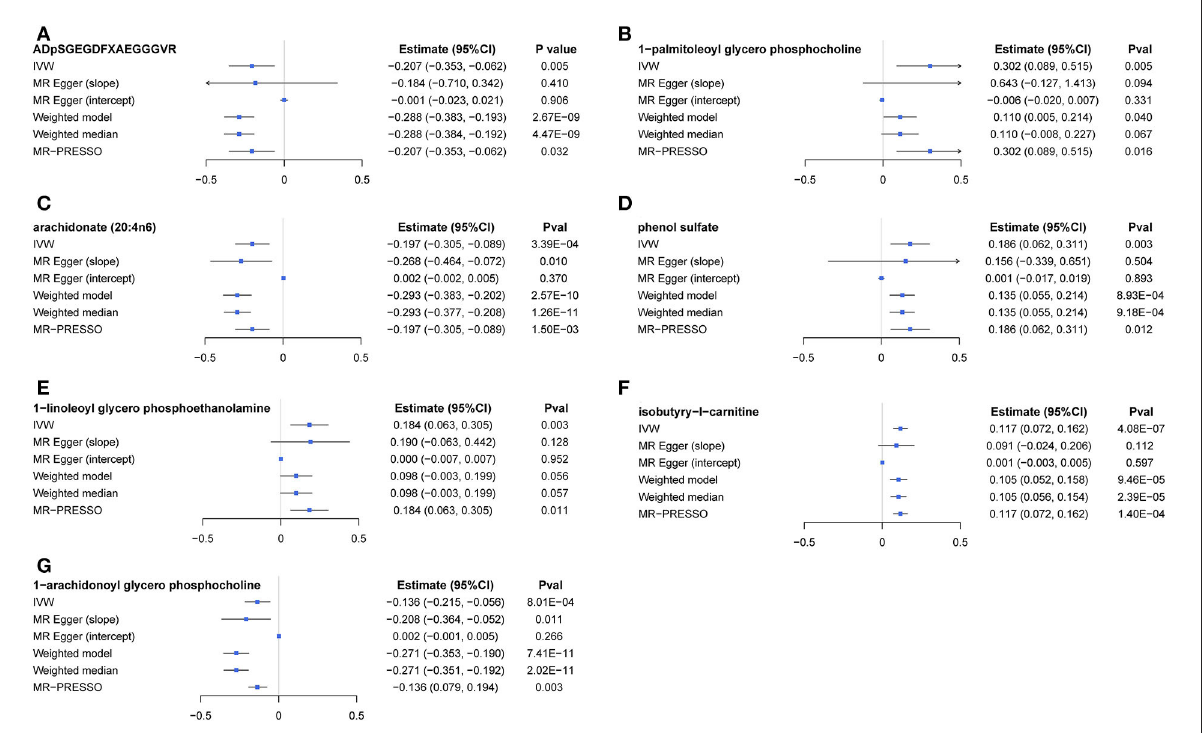
FIGURE4 A forest plot about associations between 7 causal metabolites and eBMD. (A) ADpSGEGDFXAEGGGVR ; (B) 1-palmitoleoyl glycerol phosphocholine ; (C) arachidonate (20:4n6); (D) phenol sulfate; (E) 1-linoleoyl glycerophosphoethanolamine; (F) isobutyryl-l-carnitine; (G)